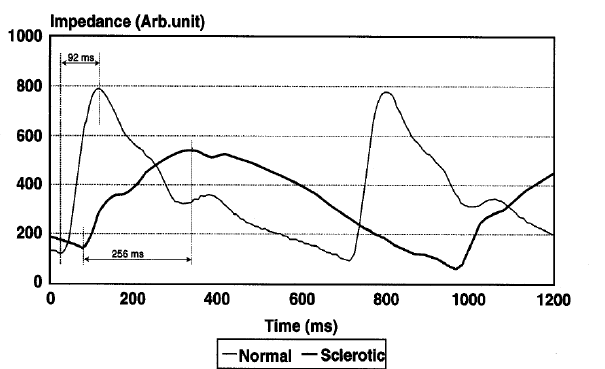
Fig.1: Typical REG curve of a healthy (normal) and a sclerotic person. Note the difference in the peak time of REG curves for normal patients (92 milliseconds) and sclerotic patients (256 milliseconds). This difference has pathological meaning, independent of heart rate [18].